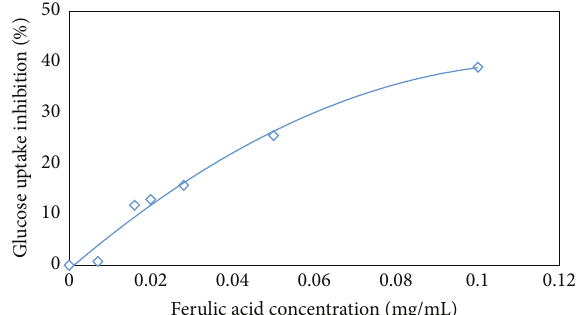
Figure 6: Glucose uptake inhibition (%) by ferulic acid in Caco- 2 cells. A plot to demonstrate that ferulic acid is the active site for inhibiting glucose absorption in Caco-2 cells. Inhibition percent was calculated from means of glucose uptake in the presence of ferulic acid or ferulic acid sugar